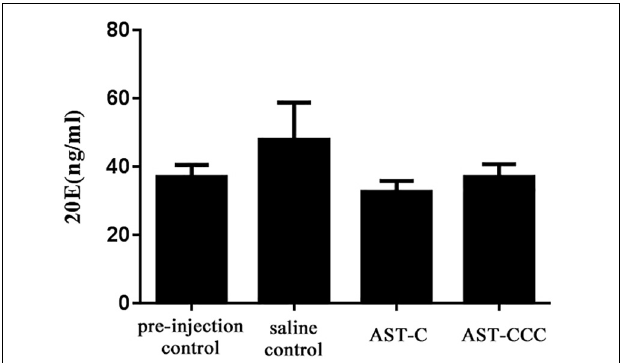
FIGURE 3 | In vivo effect of synthetic Scypa AST-C and Scypa AST-CCC peptides on 20E titer in the hemolymph of S. paramamosain. Data were shown as means ± SEM ( n = 7). No significant change in the hemolymph 20E titer was detected after administration of Scypa AST-C or Scypa AST-CCC peptide.